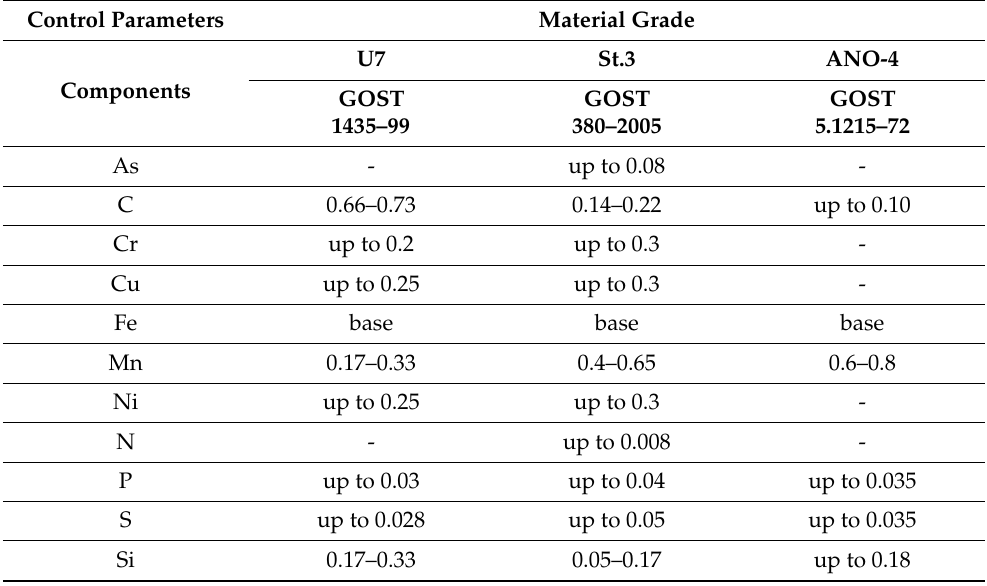
Table 1. Composition of the studied structural materials.